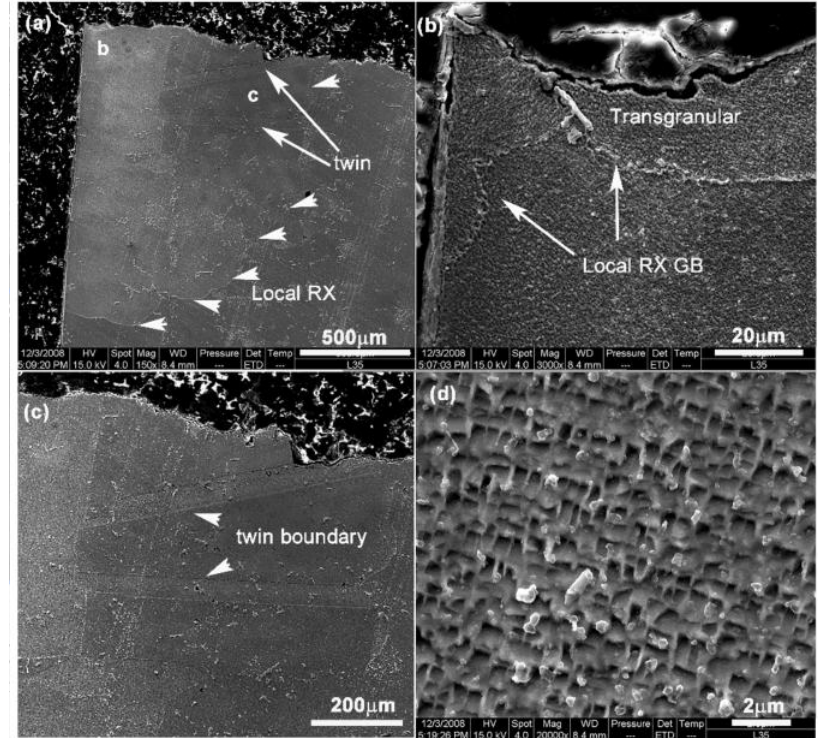
Figure 8. Longitudinal section microstructure of the SX alloy with local recrystallization at 550 ◦ C ( ε n = 0.7%, N f = 988 cycles); ( a ) overview; ( b ) transgranular fracture of recrystallized grains; ( c ) anealling twins in local recrystallized grains; ( d ) deformed microstructure in recrystallized